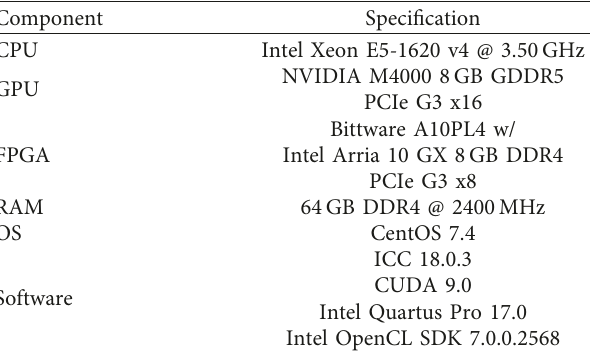
Table 4: Specifications for Dell T5000 desktop